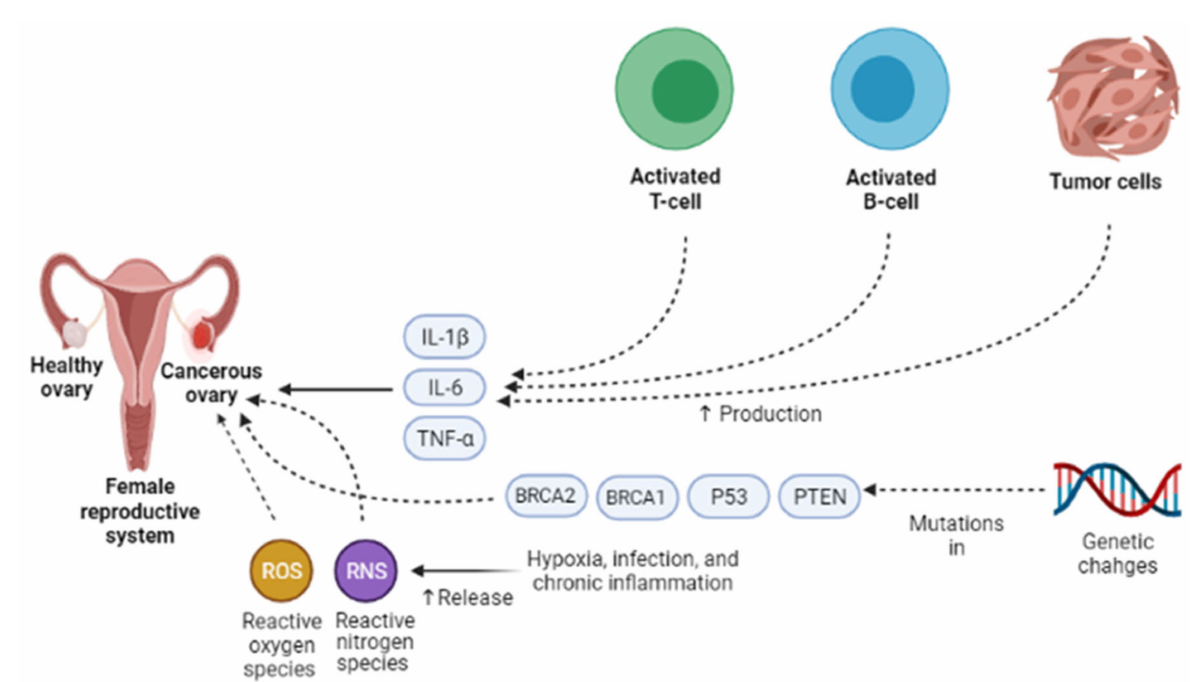
Figure 2. Different endogenous and exogenous factors modify the development and prognosis of ovarian cancer. IL- 1 β , IL-6, and TNF- α accelerate the growth of cancer cells and affect the prognosis and clinical status of the disease via increasing resistance to chemotherapy and stimulating symptoms. Exogenous factors, such as hypoxia, infection, and chronic inflammation, are the main sources of oxidative stress, namely reactive nitrogen species (RNS) and reactive oxygen species (ROS). They can contribute to ovarian cancer development via genetic instability enhancement, angiogenesis promotion, and abnormality in cell proliferation. One of the most important features of ovarian cancer is genetic changes that mediate the development and progression of tumors. In ovarian cancer, the presence of mutations in PTEN , P53 , BRCA1, and BRCA2 genes, tumor suppressor factors, can lead to ovarian cancer development. IL-1 β , Interleukin-1 β ; IL-6, Interleukin-6; TNF- α , Tumor necrosis factor α ; PTEN, Phosphatase and tensin homolog; BRCA1, Breast cancer type 1; BRCA2, Breast cancer type